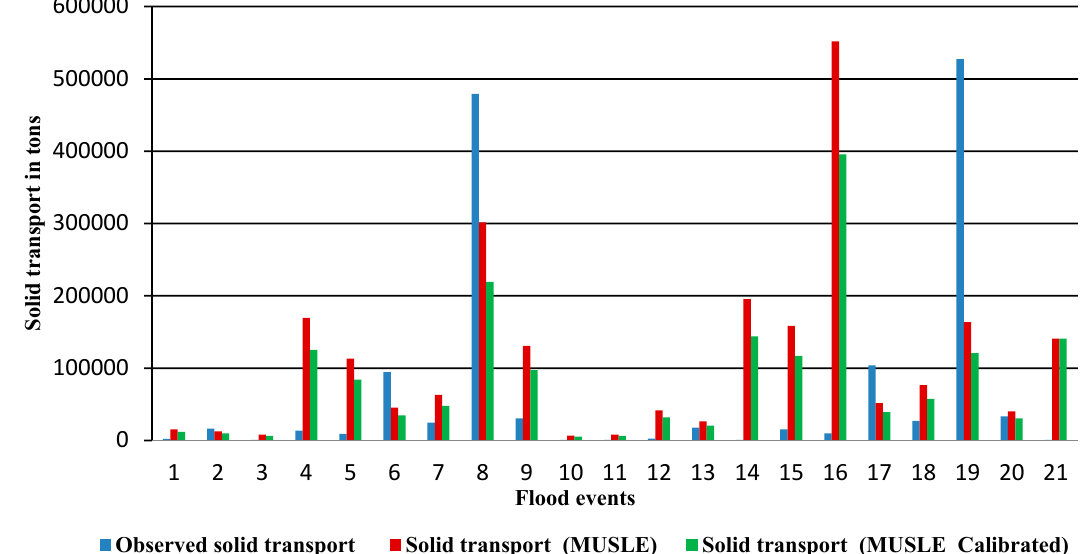
Figure 10. Comparison between MUSLE and observations at Ras Fathia on the Grou.